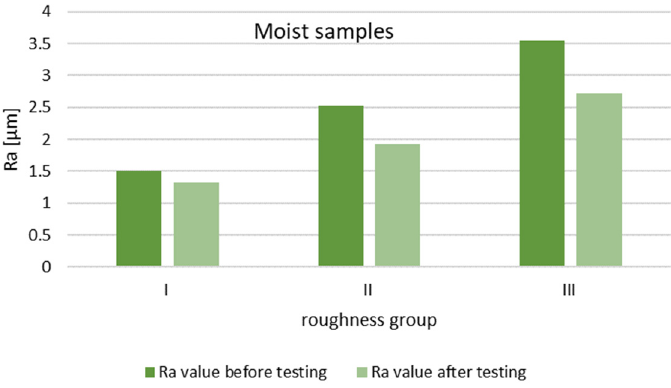
Figure 15. Change in Ra values of pin surface parameters after 30 min of operation with moist rings.